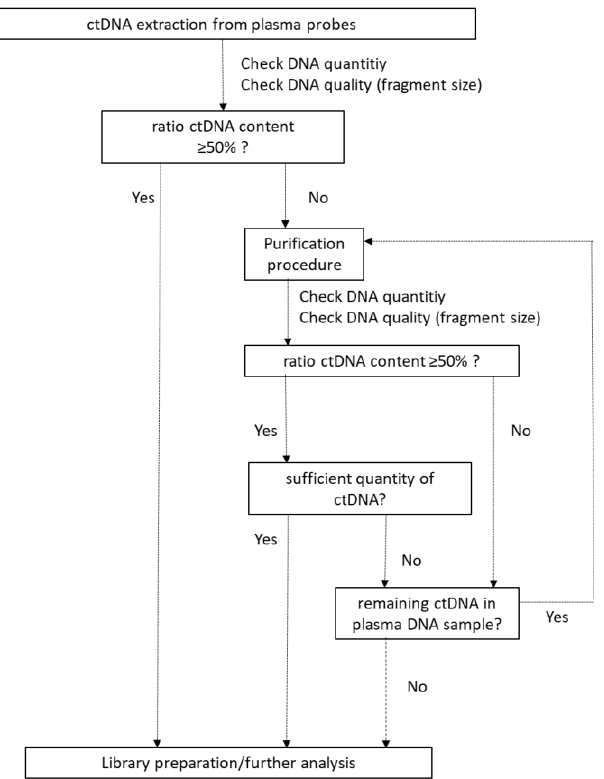
Figure 8. Decision tree for the application of the plasma DNA purification protocol. For low quality ctDNA a purification procedure is recommended. A purification procedure can be repeated until the best possible result is achieved.